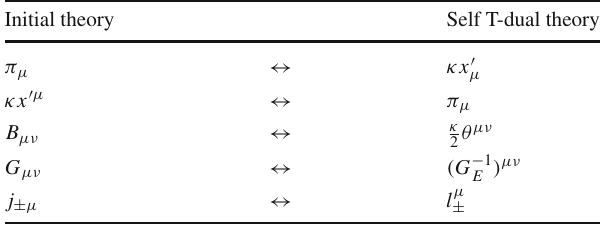
Table 2 Transformations under the self T-duality Initial theory Self T-dual